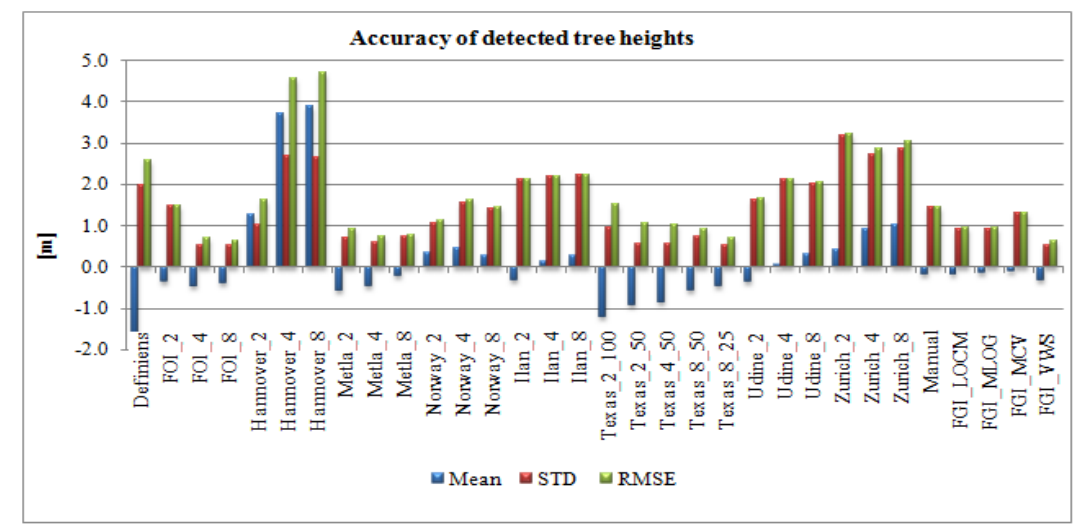
Figure 9. Accuracy of detected tree heights.